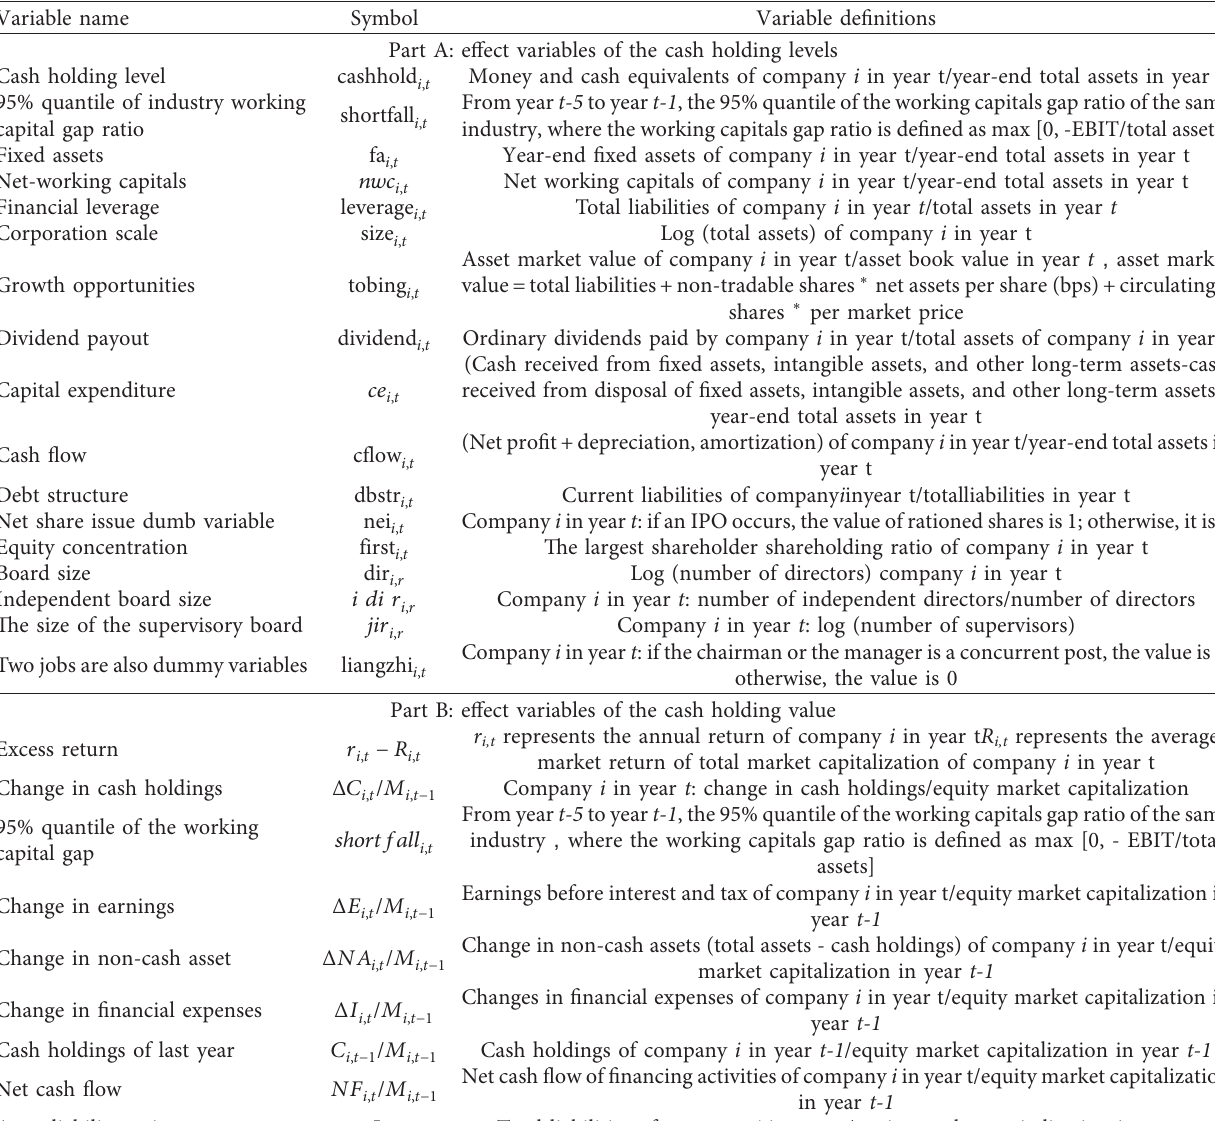
Table 1: Variable name, symbol, and